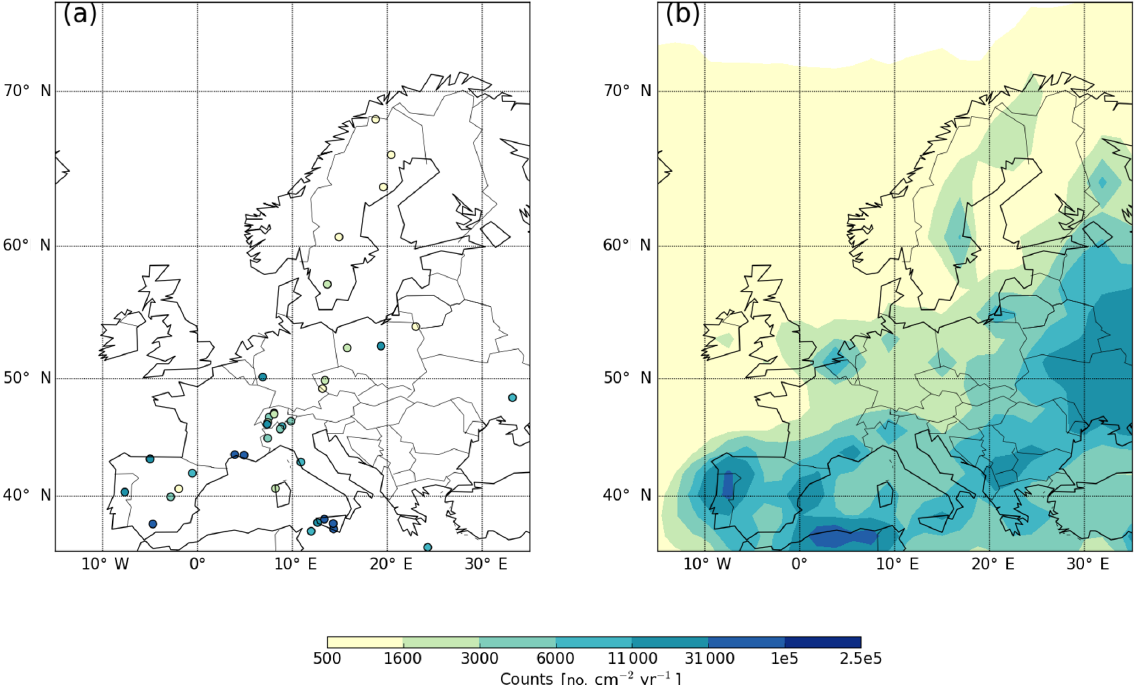
Figure 2. (a) Observed vs. (b) simulated number fluxes of charcoal particles above the threshold radius (in cm − 2 yr − 1 ) using the chosen estimate of parameters (an emission number geometric mean radius of r eq = 5µm, a threshold radius of r eq = 4 . 9µm, and a charcoal density of 0 . 6gcm − 3